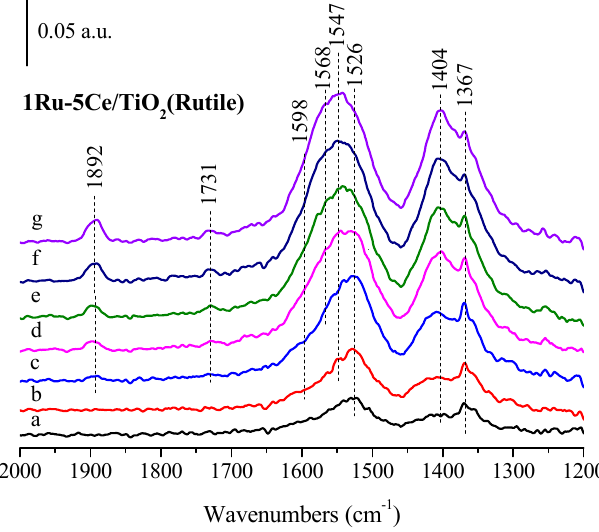
Figure 11. In situ FTIR spectra for 1Ru ‐ 5Ce/TiO 2 (Rutile) collected at 290 °C after (a) 1; (b) 3; (c) 10; (d) 20; (e) 30; (f) 60; (g) 90 min on 500 ppm benzene/Ar stream.